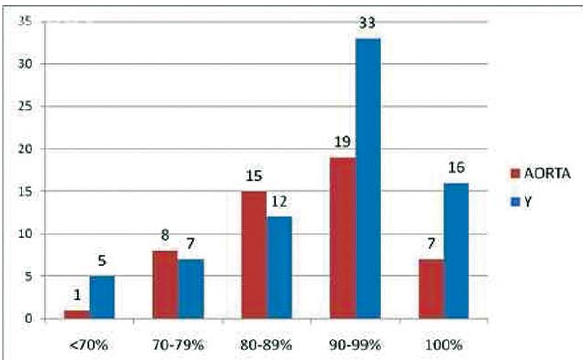
Fig. 2 - Distribuição dos diferentes graus de lesão obstrutiva, nos dois grupos de anastomose proximal